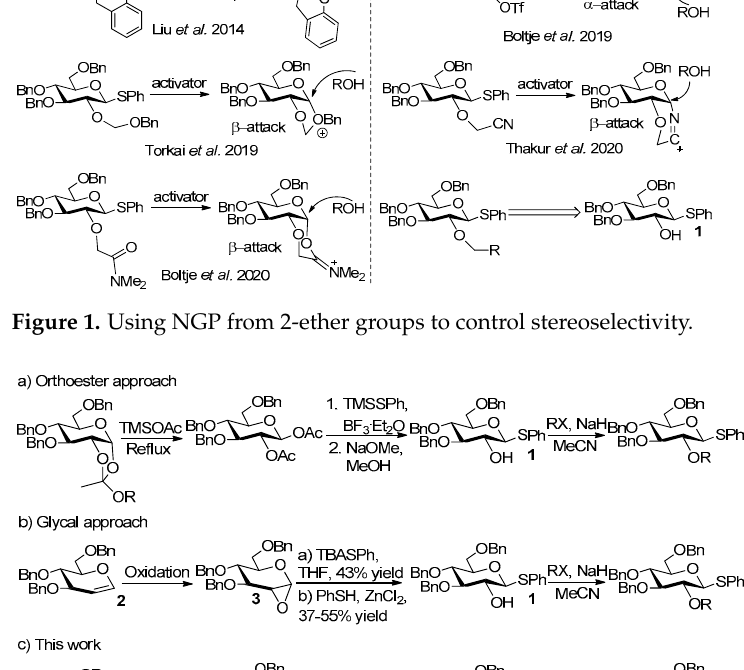
Figure 1. Using NGP from 2-ether groups to control stereoselectivity.